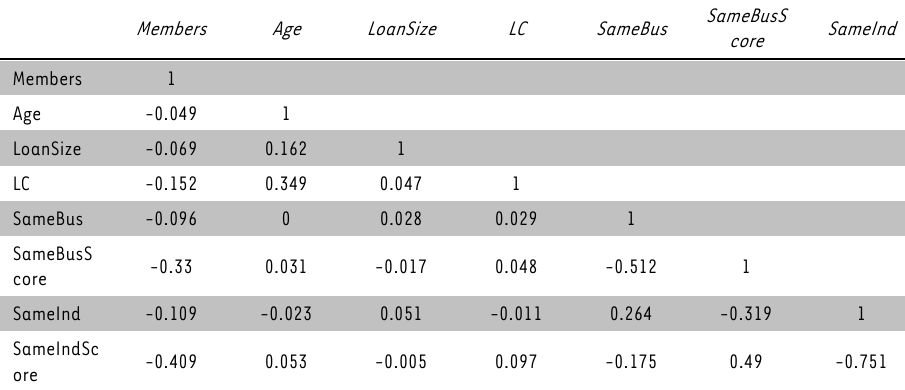
TABLE A1: Pearson’s correlation coefficient among Marang variables